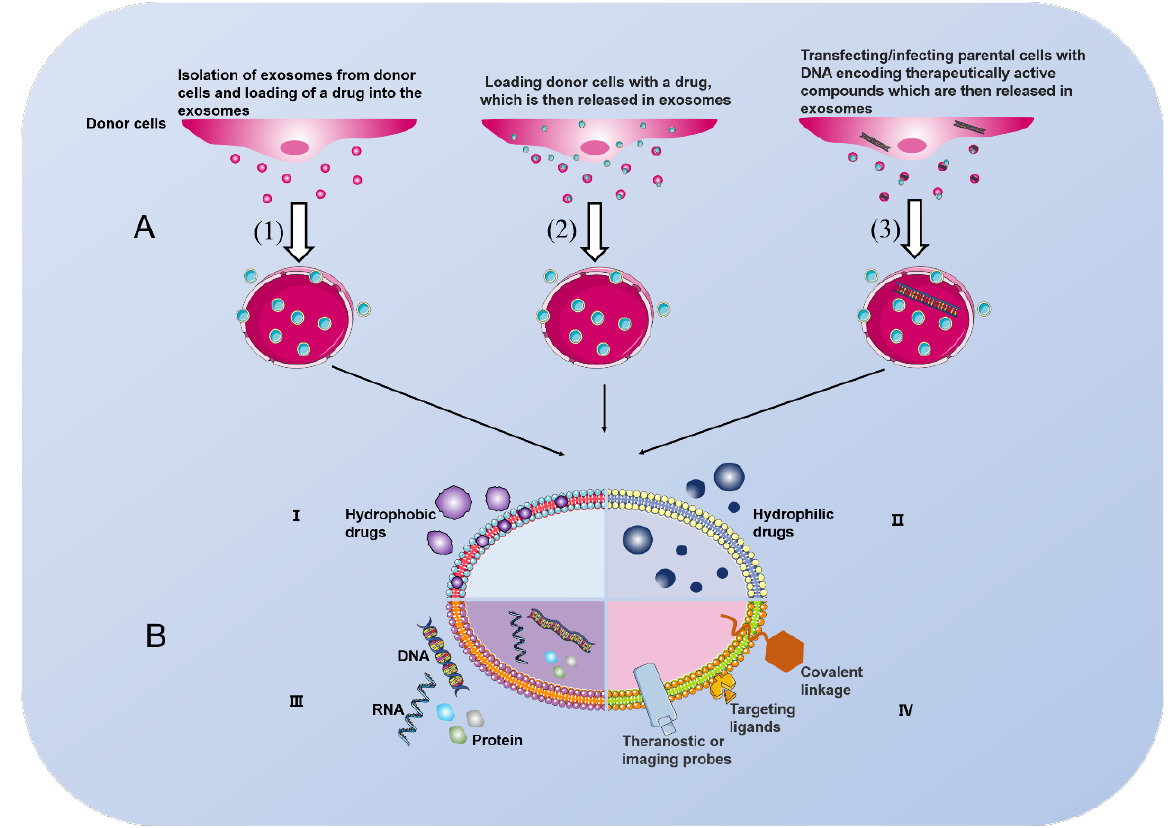
Figure 3. ( A ): Three different ways to load therapeutic “cargos” into exosomes. (1) Solation of exosomes from donor cells and integration of drugs with them. (2) Integration of drugs into donor cells, where the drugs are contained in their secreted exosomes. (3) Encoded DNA is transfected into donor cells and “cargo” is released in exosomes. ( B ): Different types of exosome drug delivery systems. Hydrophobic ( Ⅰ ) or hydrophilic ( Ⅱ ) compounds are bound in the lipid bilayer or in the aqueous phase, respectively. Exosomes can also be used for DNA, RNA, and protein delivery ( Ⅲ ). Probes, specific targeting ligands and linker bonds embedded on the surface of exosomes ( Ⅳ ).